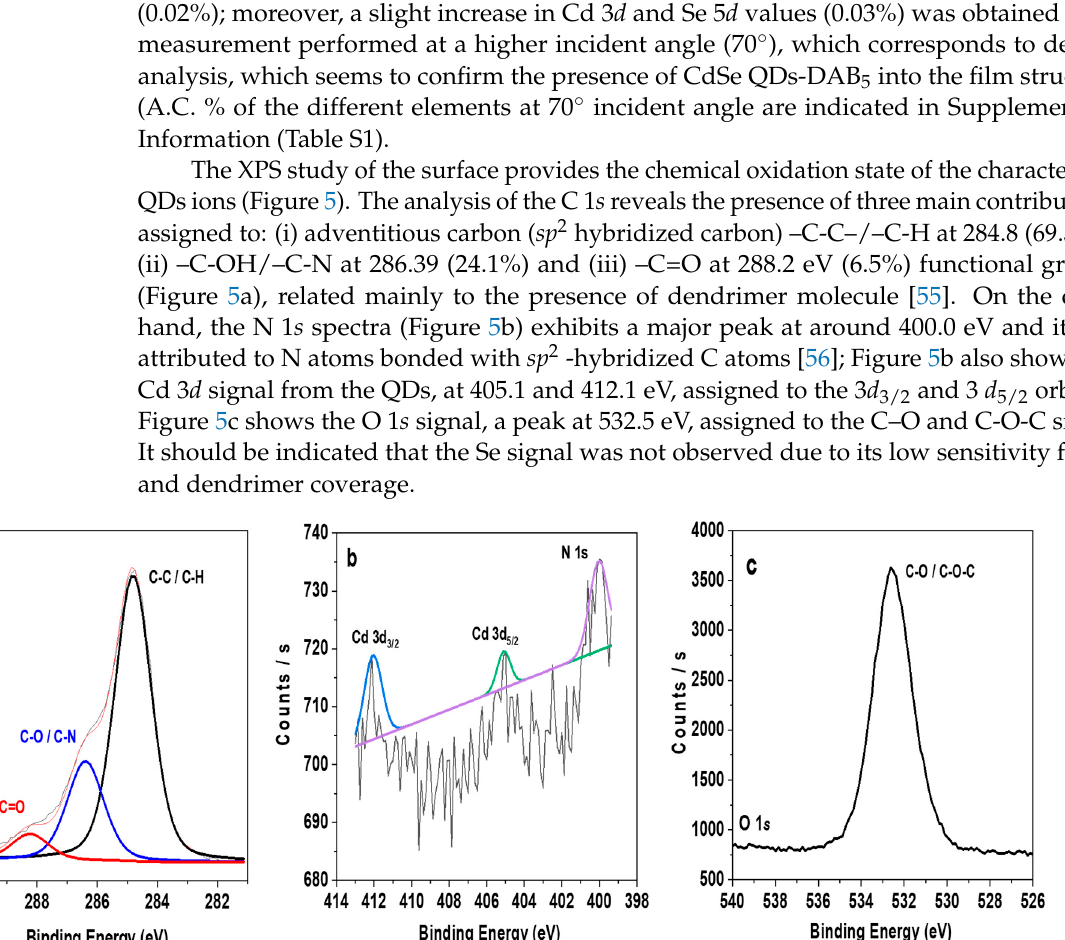
Figure 4. FE-SEM images of RC-4/CdSe-QDs@S-DAB 5 film.